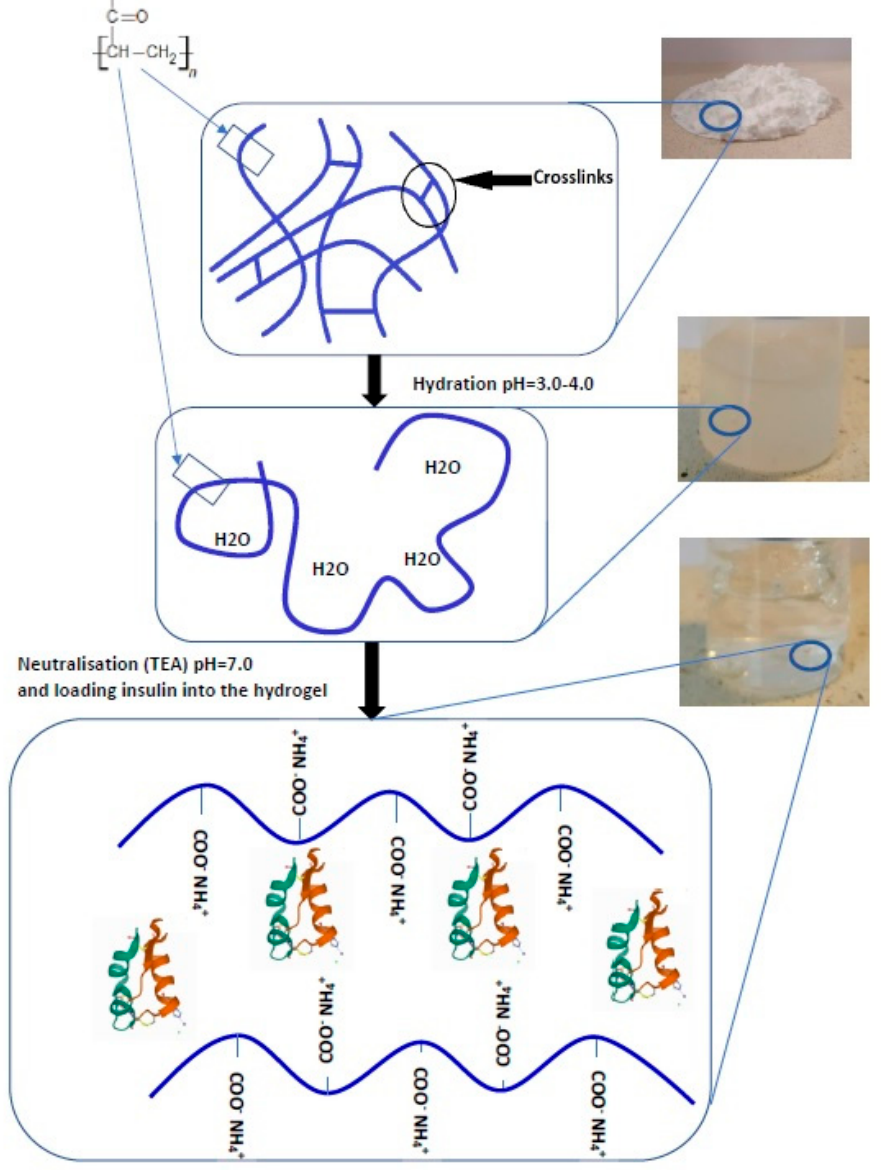
Figure 1. The schematic shows the chemical structure of Carbopol and the mechanism of thickening. Carbopol in its dry form—tightly coiled acidic molecules. Hydration—the molecules begin to hydrate and partially uncoil. Neutralization with triethanolamine (TEA)—conversion of the acidic Carbopol polymer to salt loading insulin into the hydrogels. The structure of insulin was obtained from the Protein Data Bank (PDB, http://www.rcsb.org, accessed on 25 July 2021) under code PDB 3E7Y [26].